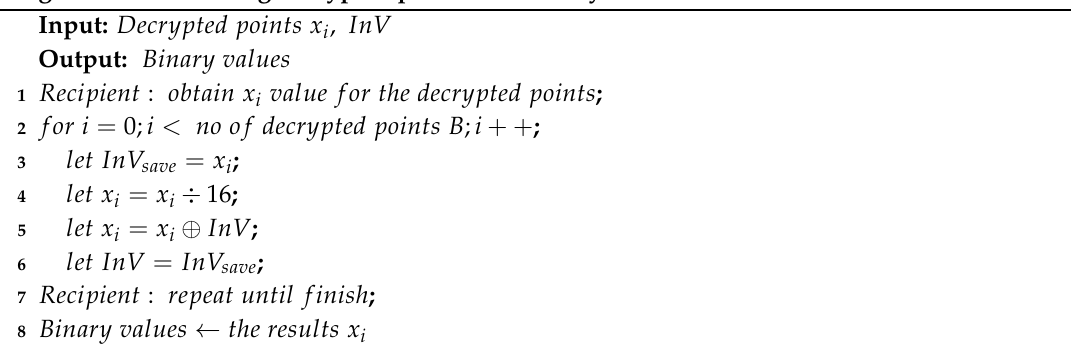
Algorithm 9: Decoding decrypted points into binary values.